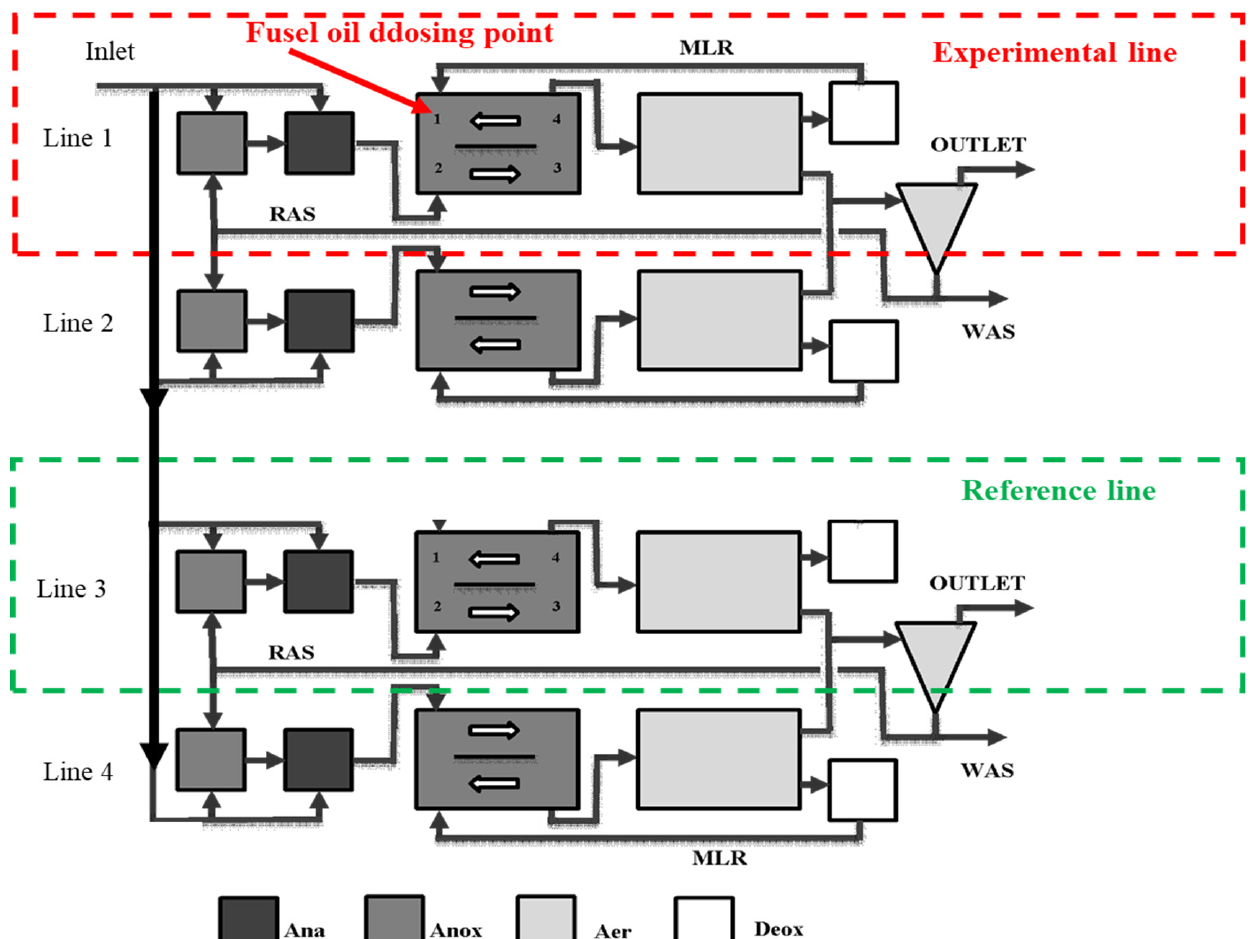
Figure 1. Layout of the full-scale JHB systems for investigating the acclimation of biomass to fusel oil at Poznan WWTP. Abbreviations: RAS—recalculated activated sludge, MLR—mixed liquor recirculation, WAS—waste activated sludge. Reactors: Ana—anaerobic, Anox—anoxic, Aer—aerobic, Deox—deoxidation of the MLR.